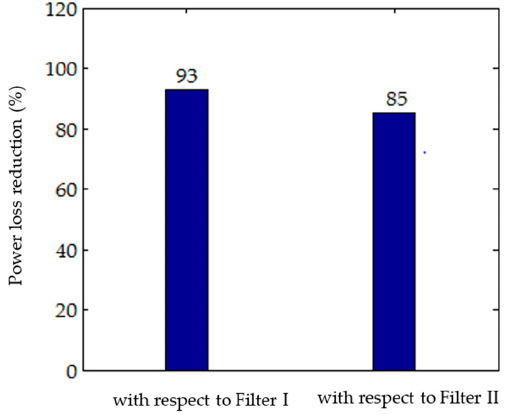
Figure 18. Damping loss reduction in Filter III.